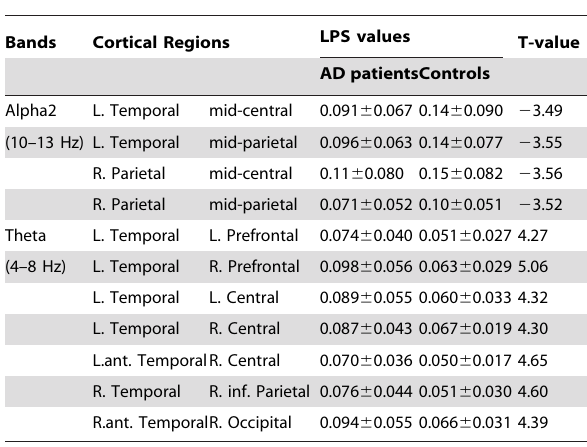
Table 3. Lagged phase synchronization values of cortical regions showing significant difference in functional connectivity between the patient and control groups.